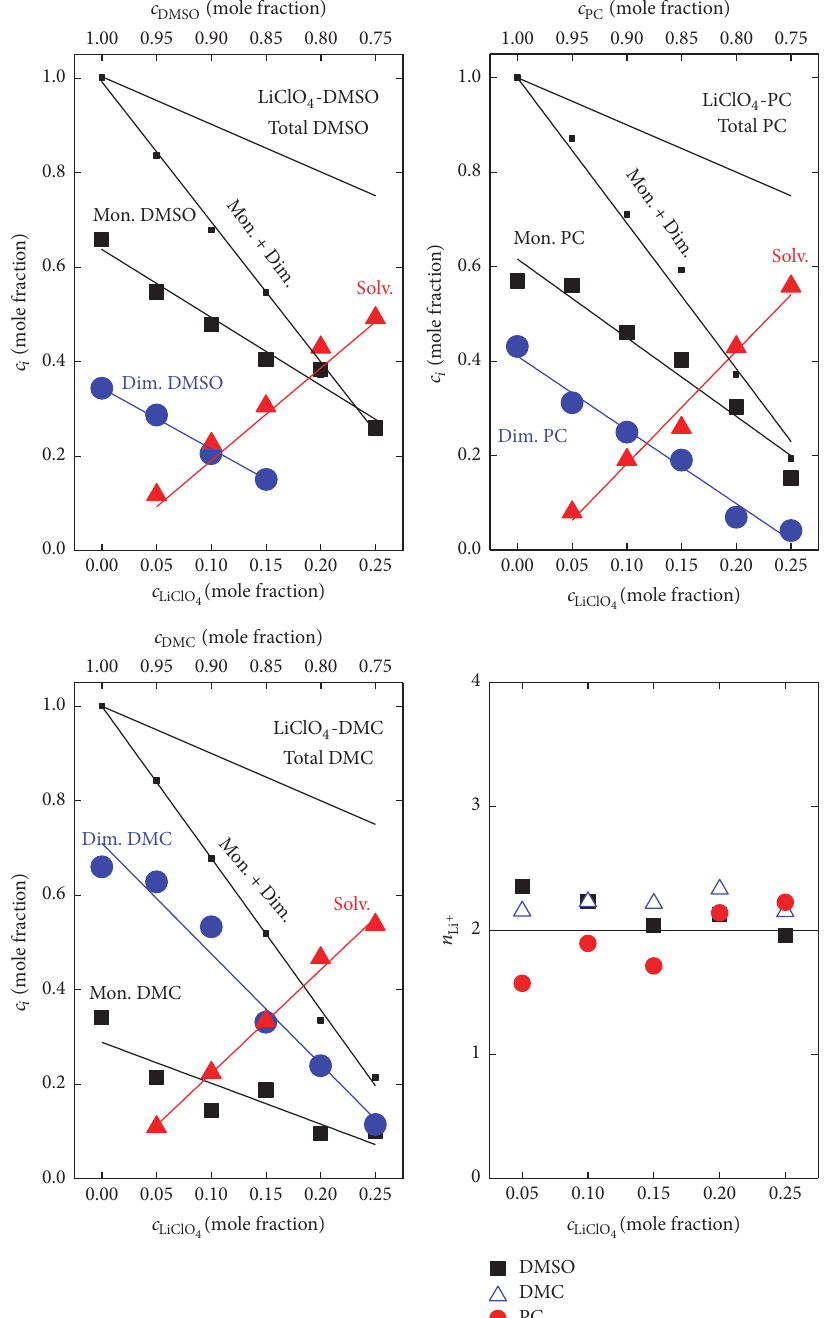
Figure 3: Concentration dependence of the amounts of monomeric, dimeric, and solvating molecules of the solvent and mean number of the solvent molecules bonded to cations in ionic solutions of DMSO, PC, and DMC.